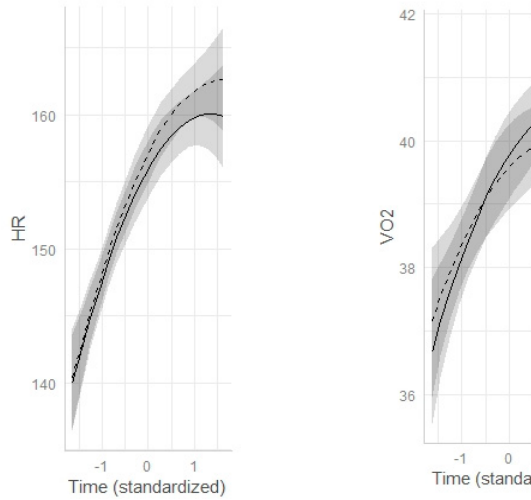
Figure A2. Predicted values from mixed-effects models of internal physical load indices. Left panel: HR as a function of task and time in the task (scaled). Middle panel: VO 2rel as a function of task and time in the task (scaled). Right panel: RER as a function of task and time in the task (scaled).